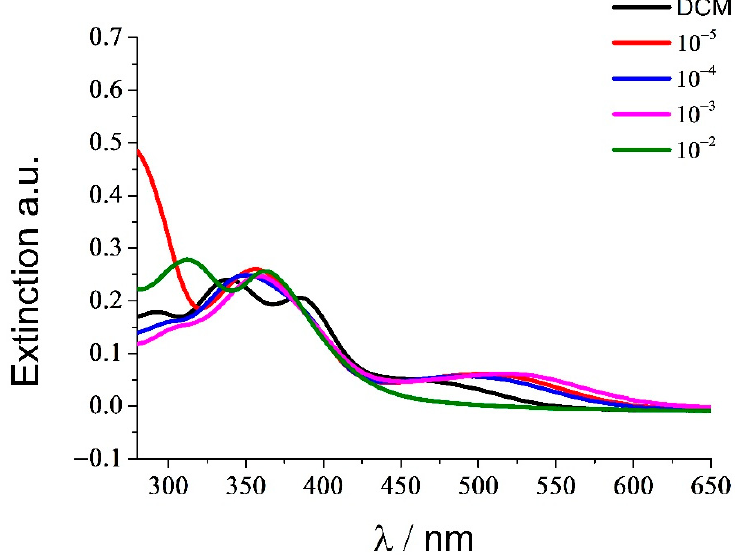
Figure 1. Optical spectra of 3 in dichloromethane and in the presence of